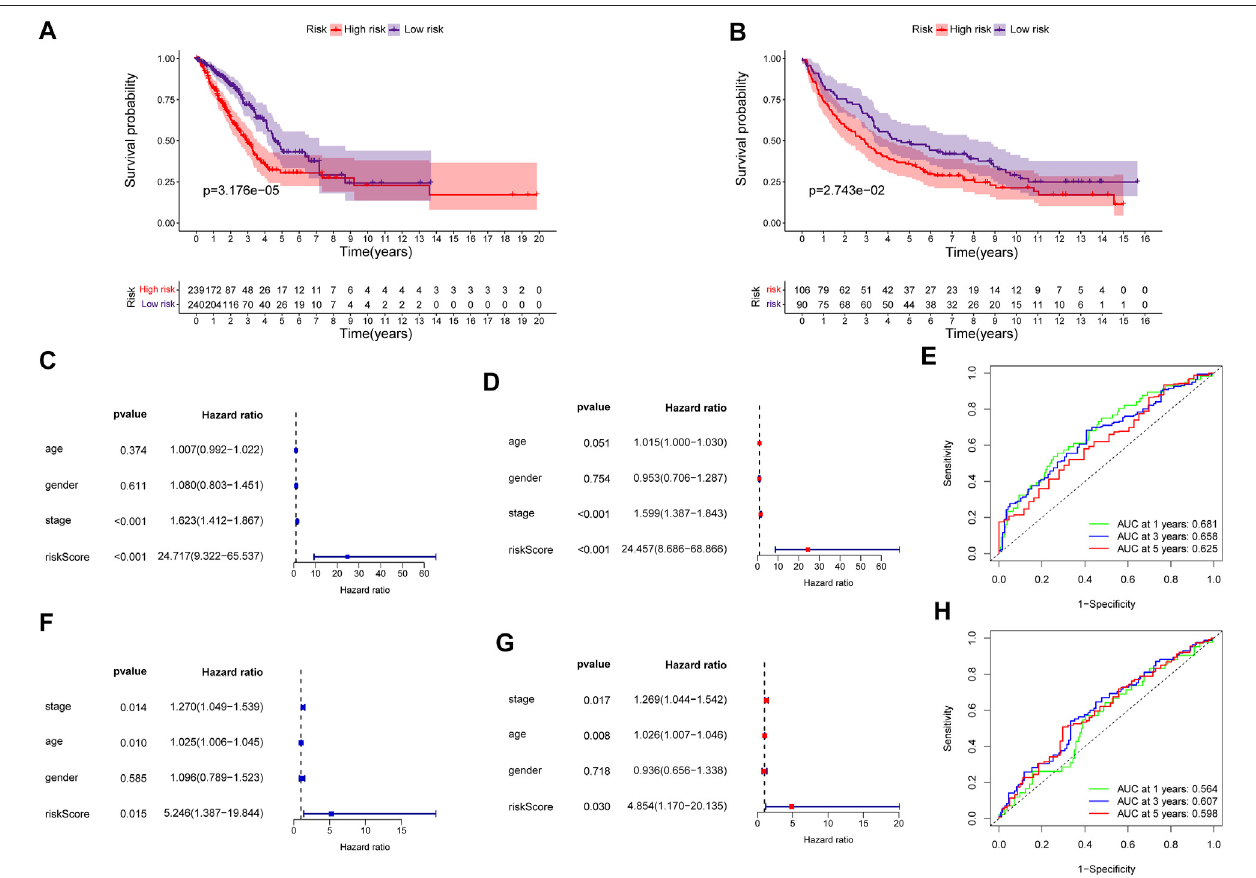
FIGURE3| ValidationoftheprognosticsignatureintheentireTCGAandGEOcohorts (A) Kaplan – Meiersurvivalcurveofthehigh-andlow-riskgroupsintheentire TCGA cohort (B) Kaplan – Meier survival curve of the high- and low-risk groups in the GEO cohort (C) Univariate Cox regression analysis of clinicopathological variables and ECMRS in the entire TCGA cohort (D) Multivariate Cox regression analysis of clinicopathological variables and ECMRSin the entire TCGA cohort (E) ROC curves of one-, three- and fi ve- years in the entire TCGA cohort indicating the predictive ability of ECMRS (F) Univariate Cox regression analysis of ECMRS and clinicopathologicalvariablesintheGEOcohort (G) MultivariateCoxregressionanalysisofECMRSandclinicopathologicalvariablesintheGEOcohort (H) ROCcurvesof one-,three-and fi ve-yearsintheGEOcohortindicatingthepredictiveabilityofECMRS.TCGA=TheCancerGenomeAtlas;GEO=GeneExpressionOmnibus;ECMRS = extracellular matrix-related